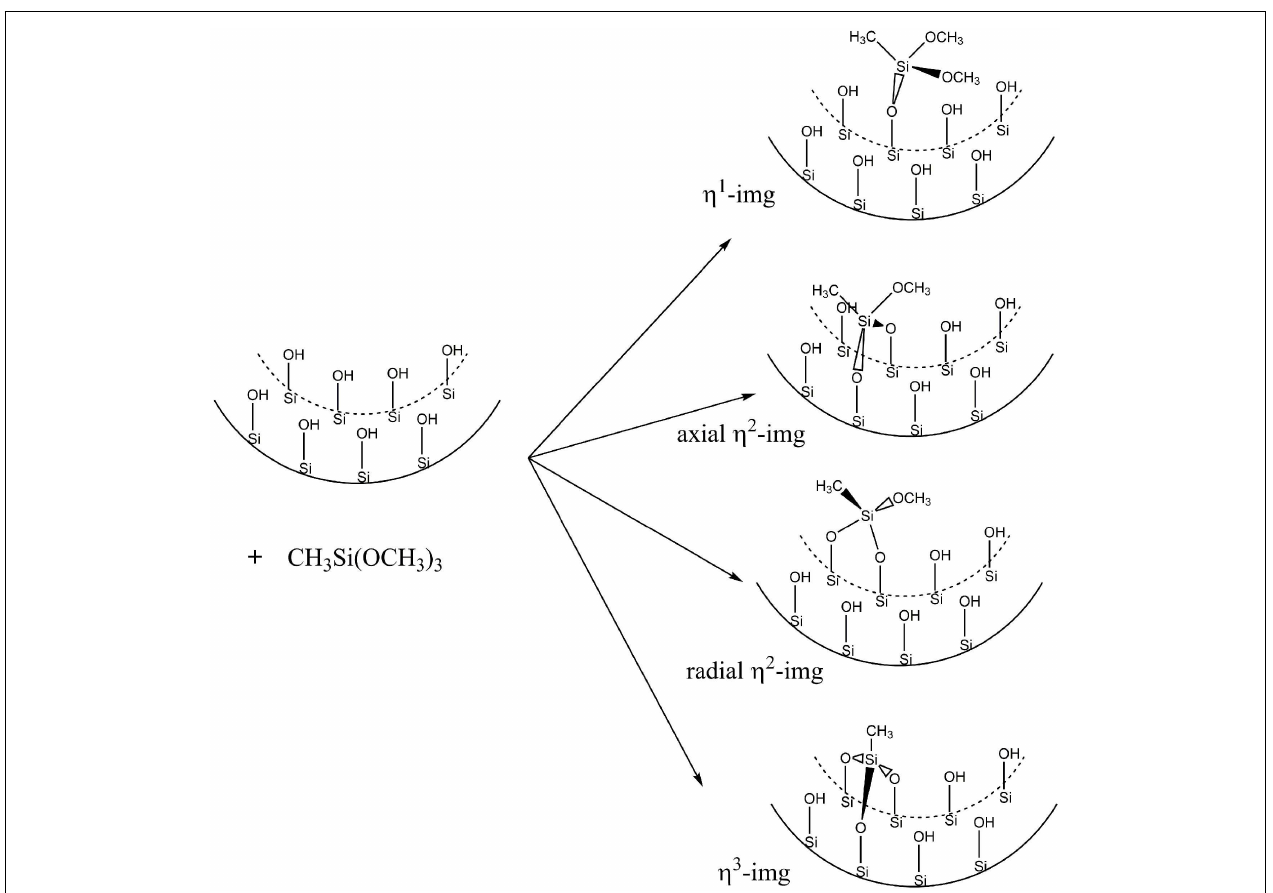
FIGURE 4 | Inner surface representations for the modified zigzag (12,0) imogolite NT